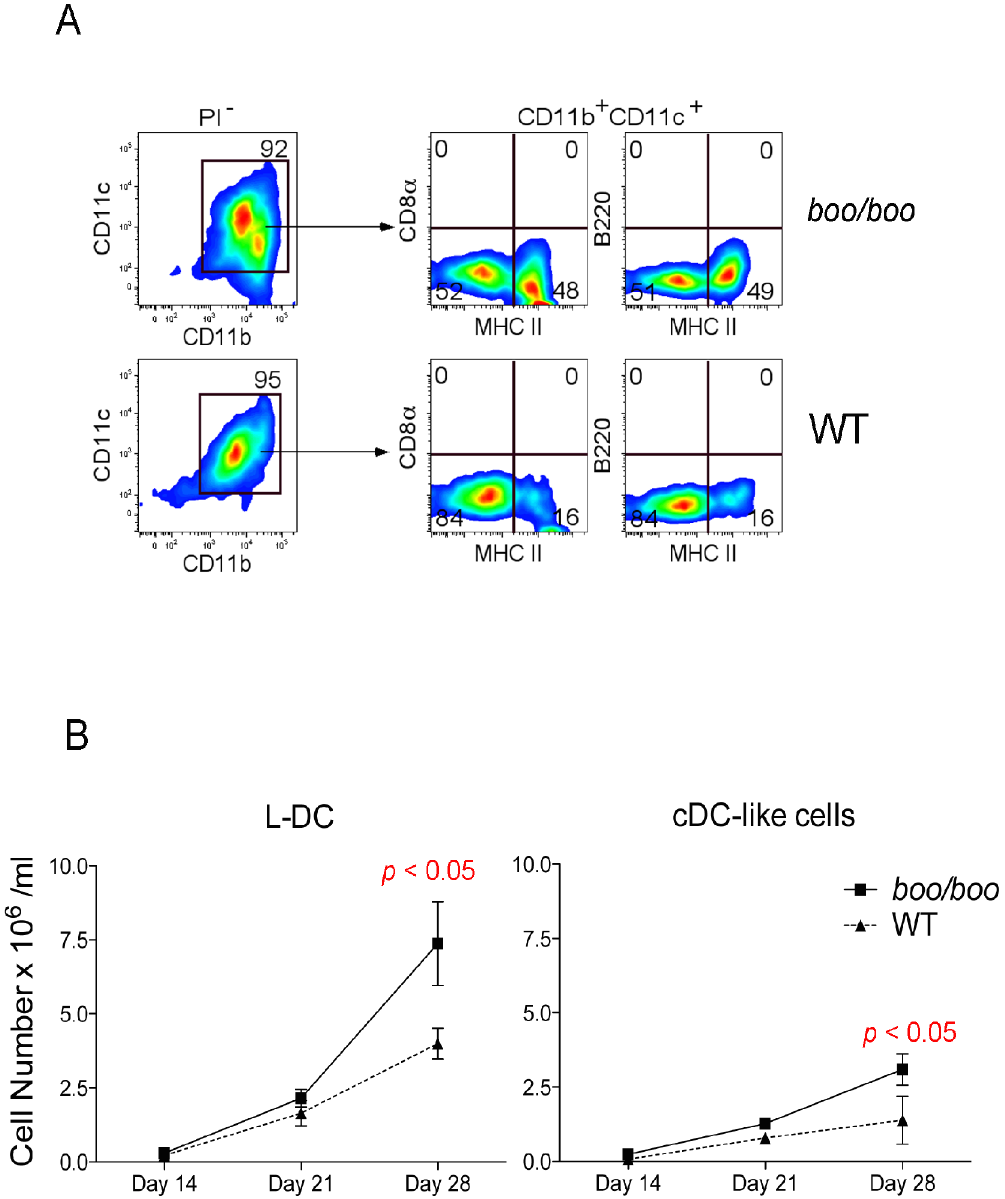
Fig 7. Hematopoiesis due to booreana ( boo/boo ) and WT bone marrow in co-cultures. Bone marrow was preparedfrom one-yearold chimeras describedin Fig 1. Donor-derived CD45.2 + bone marrow cells were sorted as a Lin - populationof boo/boo or WT origin, and equal numbers co-cultured over 5G3 splenicstroma. Individualco- cultures were established from 4 boo/boo chimeras and 2 WT chimeras.Cell production was monitoredover time by staining non-adherent cells using antibodies to CD11c, CD11b, MHC-II, and CD8 α ,or with isotype controls. Propidiumiodide(PI; 1 μ g/ml) stainingwas used to gate live cells (PI - ). Gates were set on bivariate plots using isotype control antibodies, and numbersshown in gates reflect % positive cells. (A) Data shows staining of 21 day co-culturesestablished from one of each chimera type. L-DCs were gated as CD11c lo CD11b hi MHC II - CD8 α - B220 - cells, and cDC-likecells as CD11c hi CD11b lo MHC II + CD8 α - B220 - . (B) Cell productionwas calculatedand shownas mean ± SE for co-cultures established from boo/boo ( n = 4) and wild-type (WT) ( n = 2) chimeras. Significantly different data pairs are indicated.